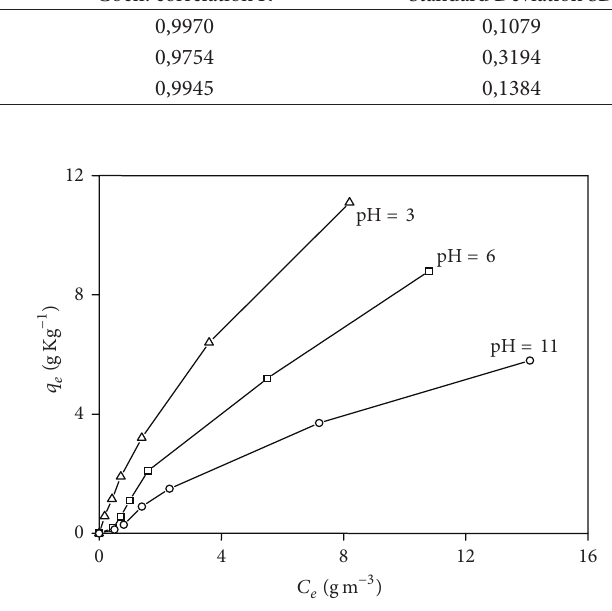
F 5: Equilibrium adsorption of reactive dye on cellulose �bers-